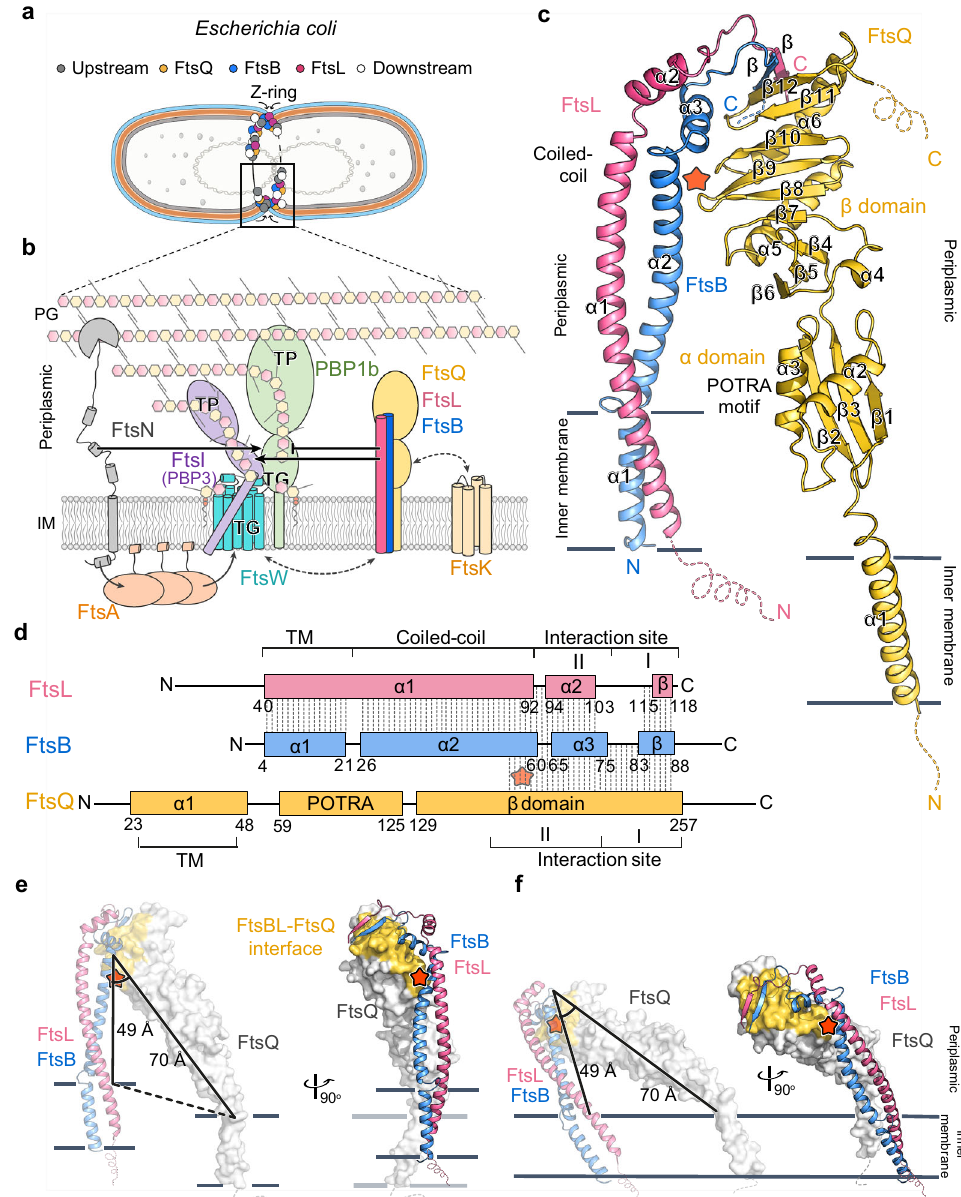
Fig. 1 | The FtsB-FtsL-FtsQ (FtsBLQ) complex in the bacterial divisome and its overallstructure.a AschematicviewoftherecruitmentofFtsBLQtothedivisome in E. coli . Divisome proteins are shown as circles: FtsB (blue); FtsL (pink); FtsQ (yellow); the upstream (black) and downstream (white) proteins of FtsBLQ. The inner and outer membranes and the periplasm are shown in grey, light blue, and orange layers. b A cartoon model of the molecular relationship between key divi- some proteins at the division site: FtsBLQ (blue, pink, and yellow), FtsK (only TM domainshown,wheat),PBP1b(green),FtsW-FtsI(cyanandpurple),FtsN(grey)and FtsA (orange). Solid black arrows/lines indicate the activating/inhibitory regula- tions.Dashedlineswitharrowsindicatetherecruitment.Theinnermembrane(IM) is drawn as a grey lipid bilayer, and peptidoglycan (PG) sugars as hexagons. c Overall structure of the FtsBLQ complex as an inverted “ V ” shape, showing FtsB